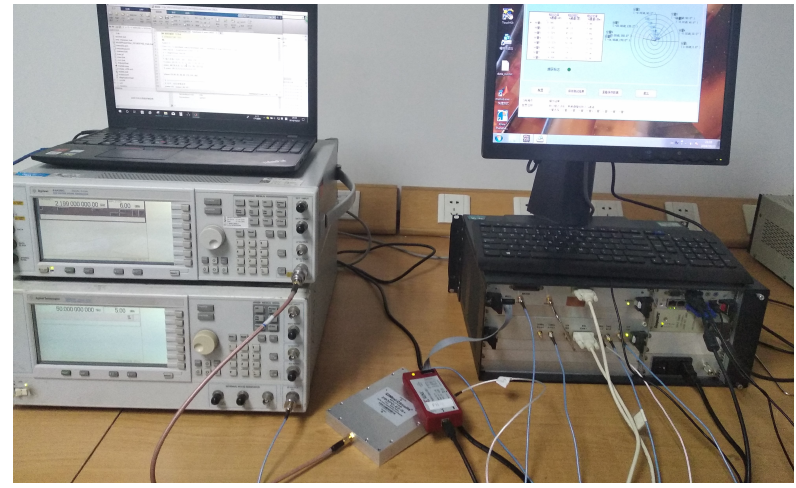
Figure 10. Experimental system for calibration.